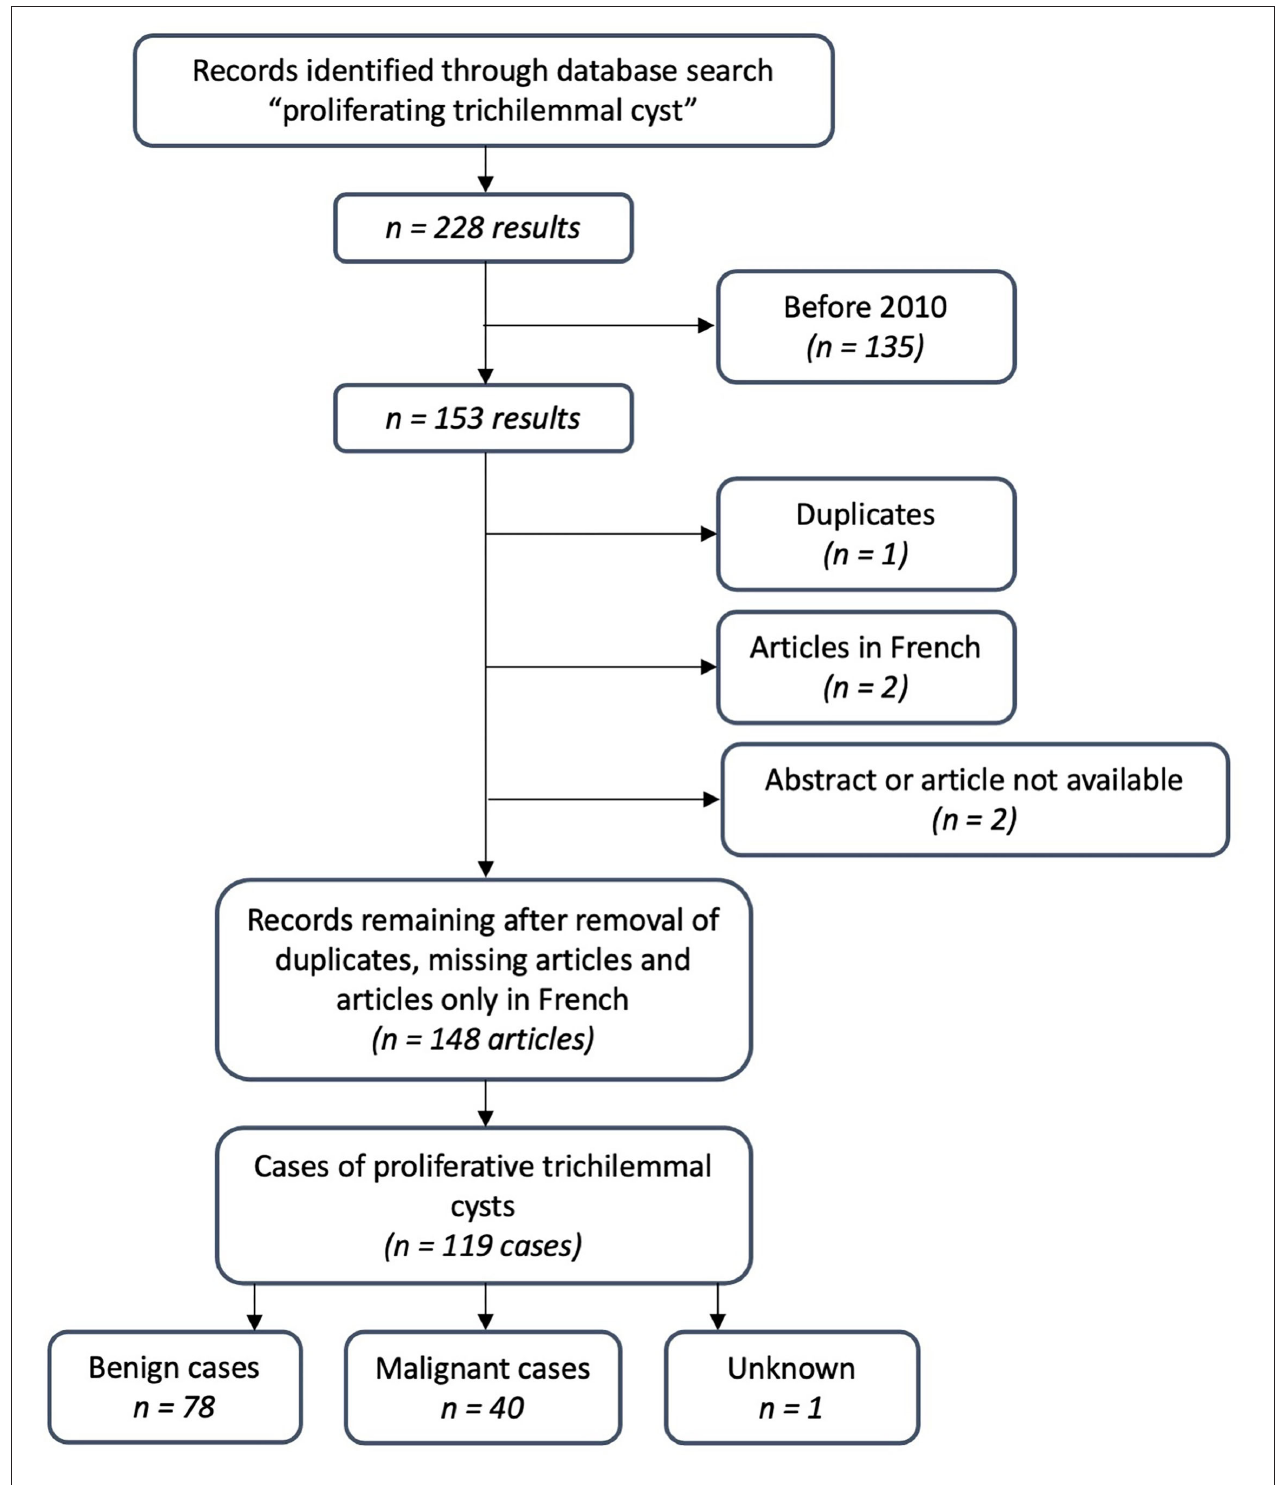
FIGURE 4 | A flowchart of literature